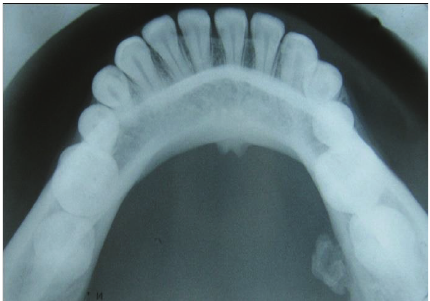
Figure 2: Mandibular occlusal cross-sectional radiograph.